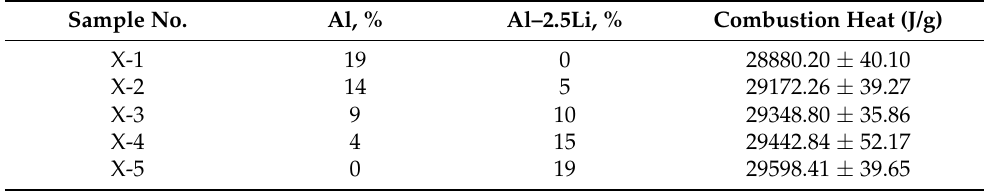
Table 3. Combustion heat of Al–2.5Li alloy, Al and their mixtures. Sample